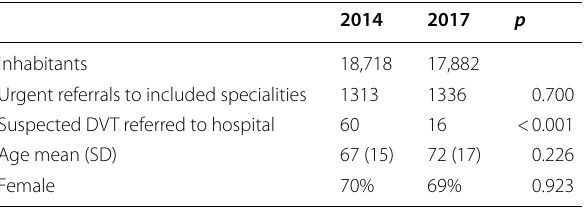
Table 1 Demographics, number of urgent referrals, and referrals due to a suspected DVT from Saarikka to Central Finland Central